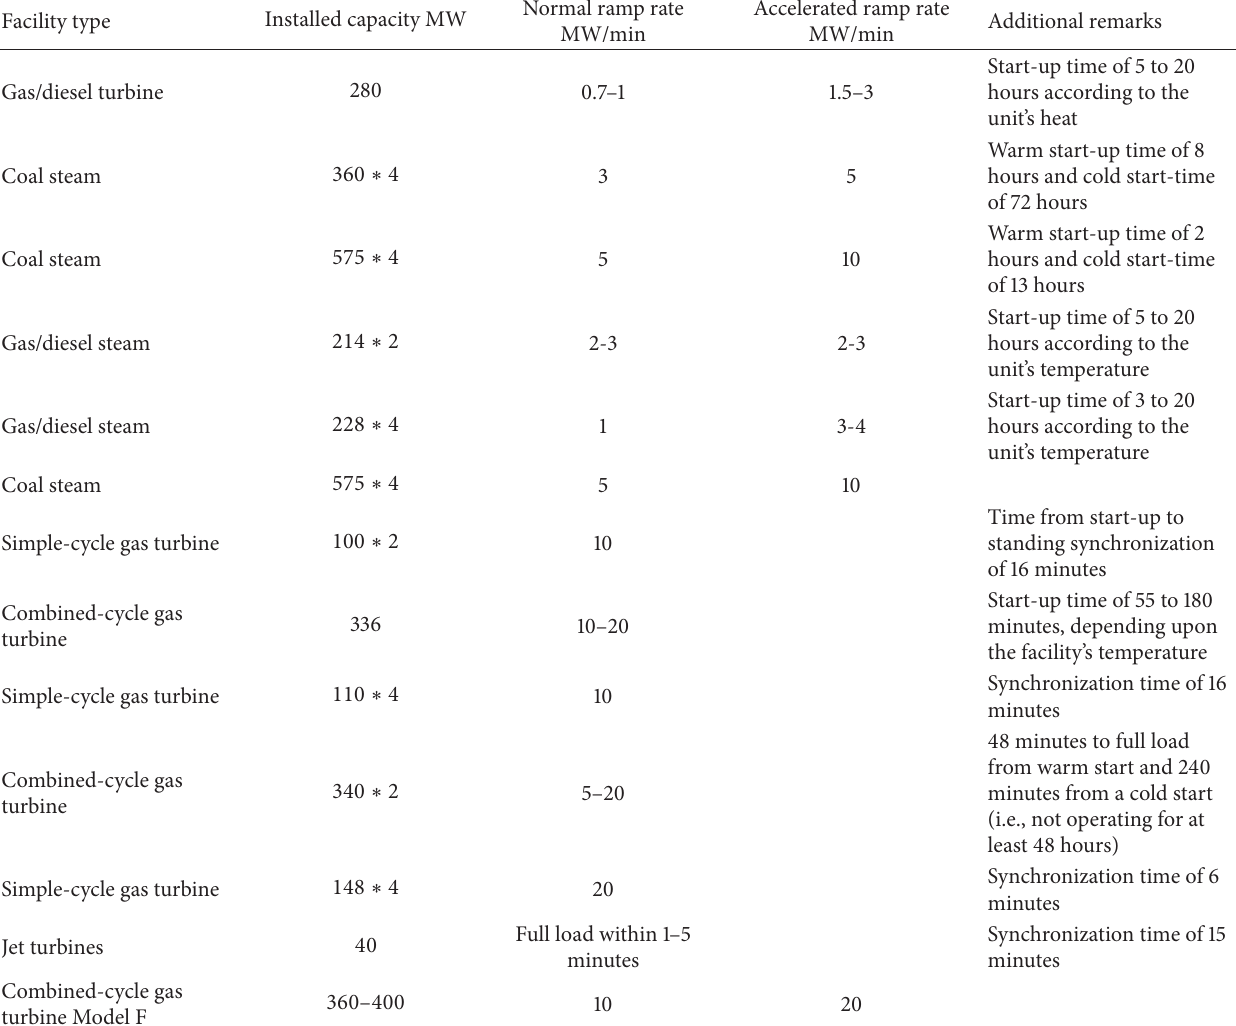
Table 1: Reaction time of generating facilities.